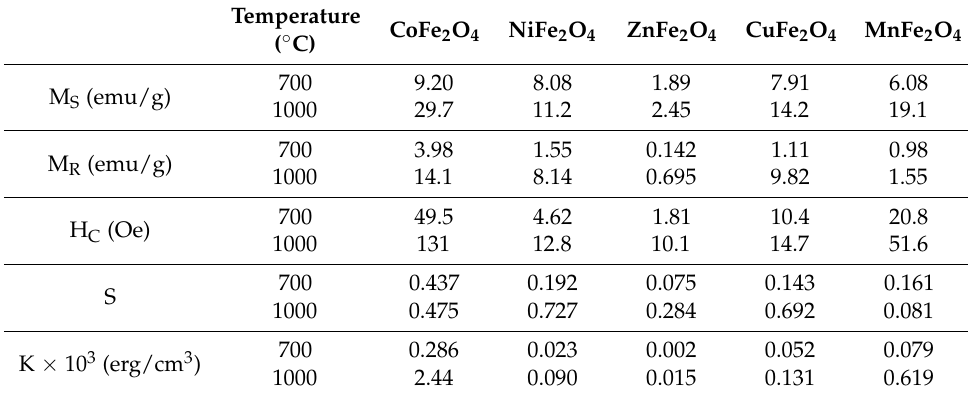
Table 2. Saturation magnetization (M S ), remanent magnetization (M R ), coercivity (H C ), squareness (S) and magnetic anisotropy constant (K) of MFe 2 O 4 (M = Co, Zn, Ni, Cu, Mn) heat treated at 700 and 1000 ◦